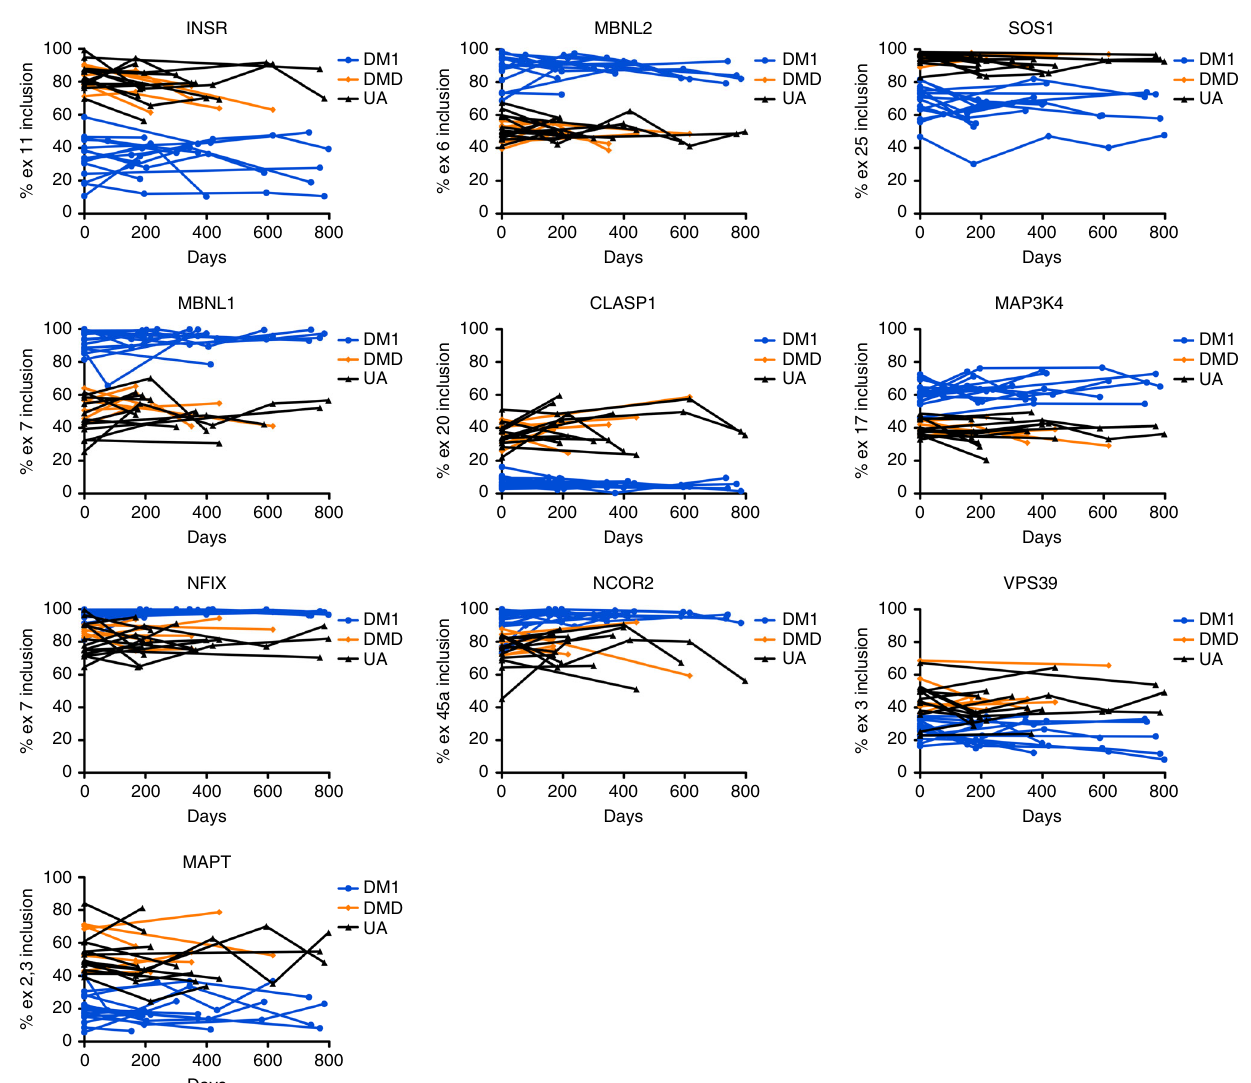
Fig. 3 Longitudinal analysis of exRNA alternative splicing in human urine. We collected two or more urine specimens from 15 DM1, 5 DMD/BMD, and 13 UA subjects over the course of several months and examined exRNA splicing outcomes by RT-PCR. Note that due to low collection volume, low RNA recovery, and/or exhaustion of cDNA samples from testing 33 overall splice events and 7 transcripts by ddPCR, longitudinal data for NCOR2 are available from only 14 DM1 subjects, CLASP1 and NCOR2 from only 12 UA subjects, and several transcripts are missing 2-year data points for one or two DM1